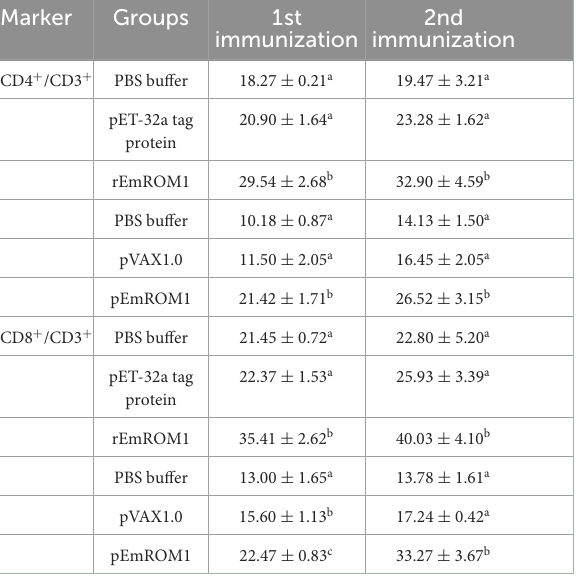
TABLE 1 The proportion of T cell subpopulation in the spleen of immunized chickens ( n = 5, value = Mean ± SD).